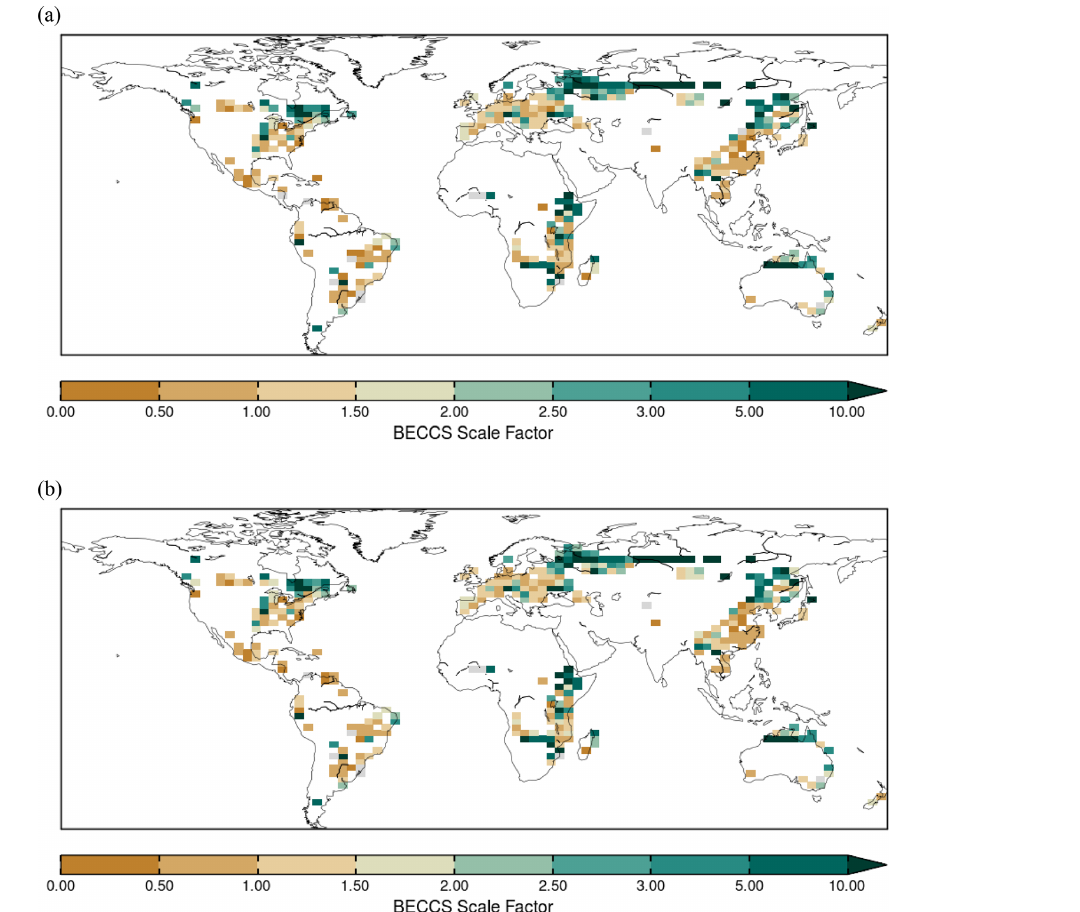
Figure 7. Scale factor required for BECCS to be the preferable mitigation option, as opposed to natural land carbon uptake. The data represents the median of the 136-member ensemble for the optimised land-based mitigation simulation. Panel (a) is for stabilisation at 1.5 ◦ C, and panel (b) is for stabilisation at 2 ◦